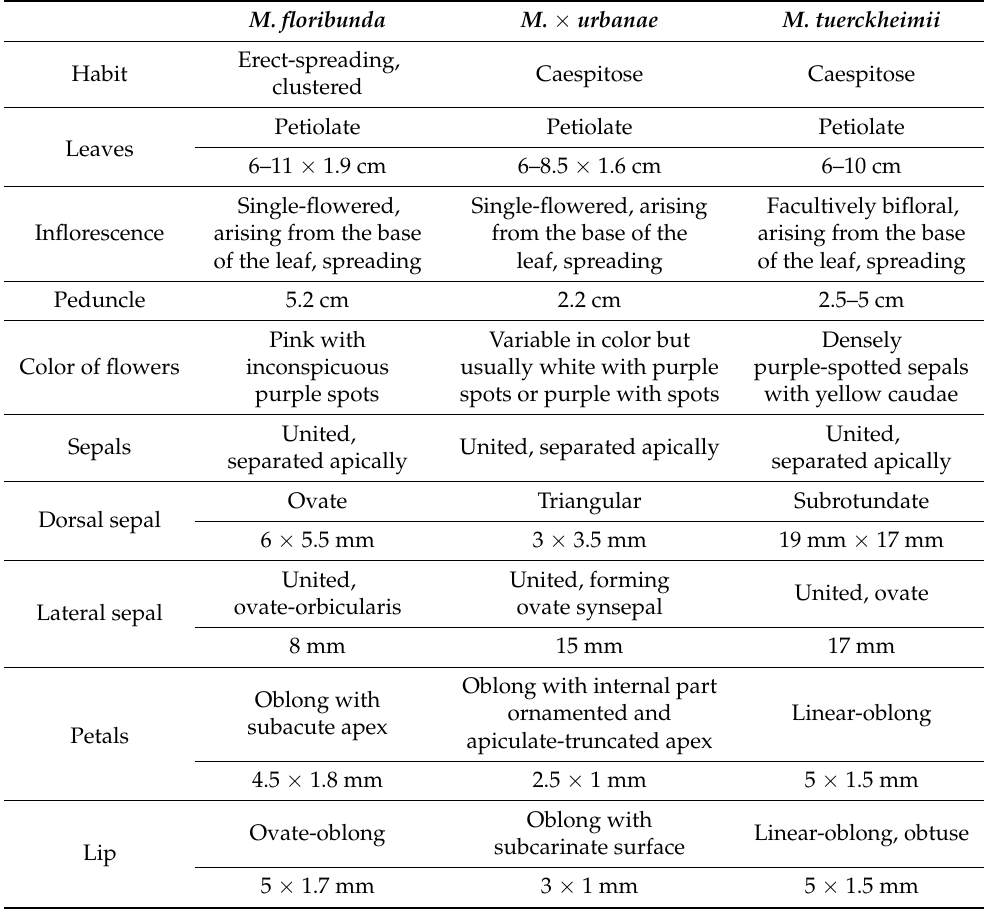
Table 1. Table showing the morphological differences of Masdevallia × urbanae by its parental